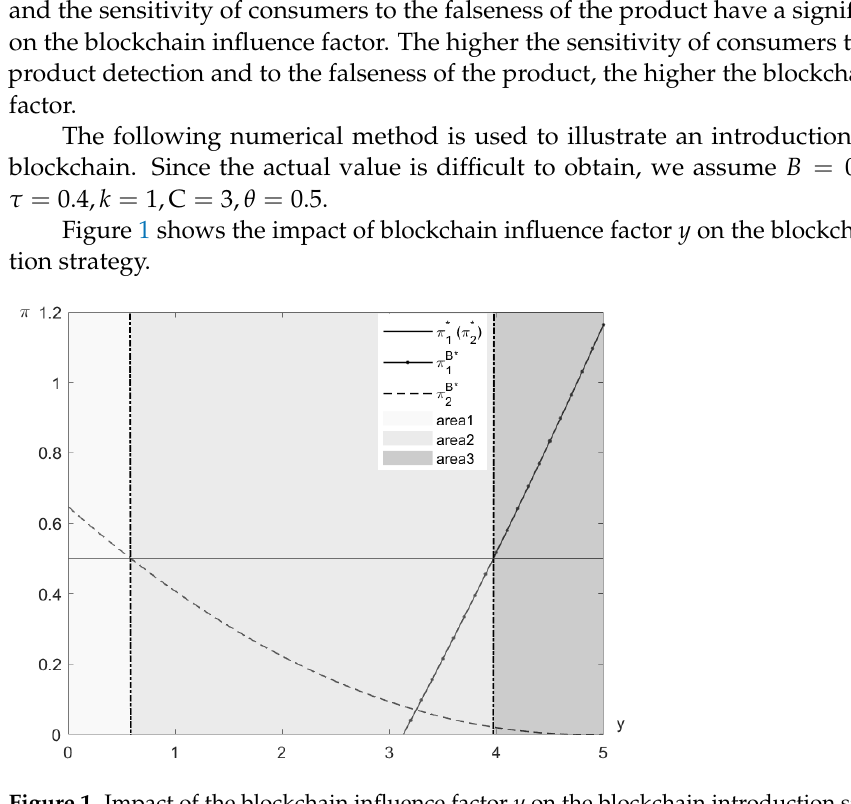
Figure 1. Impact of the blockchain influence factor 𝑦 on the blockchain introduction strategy.